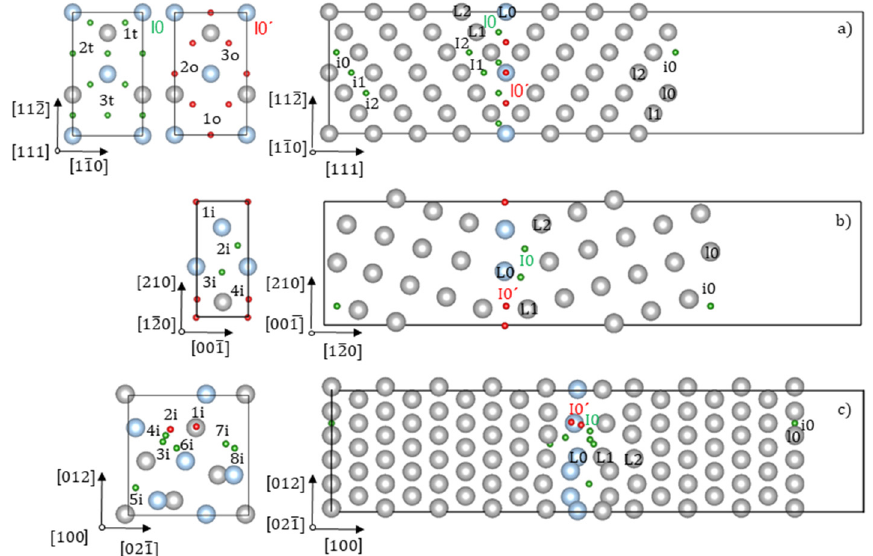
Figure 2. Schematic structures of ( a ) the coincident site lattice (CSL) Σ 3(111) [1–10] grain boundary (GB) and (111) free surface (FS); ( b ) the CSL Σ 5 (012) [100] GB and (012) FS; ( c ) the CSL Σ 5 (100) [001] GB and (001) FS used in this work. Capital / not capital letters of the numbers of layers and H positions refer to GB / FS, respectively. The red spheres correspond to H interstitial sites located in the GB plane. The green spheres correspond to H interstitial sites located outside the GB plane. The view is normal to the GB planes; and no labels are used for the demonstration of the possible tetrahedral and octahedral sites of H in the I0 and I0´ layers for the case of Σ 3(111) [1–10] and no labels for the H positions in the cases of Σ 5 (012) [100] and Σ 5 (100) [001]. I0 and I0´ labels are referred to the first layer of H located directly at the GB layer and the next to GB layer, which correspond to the octahedral and